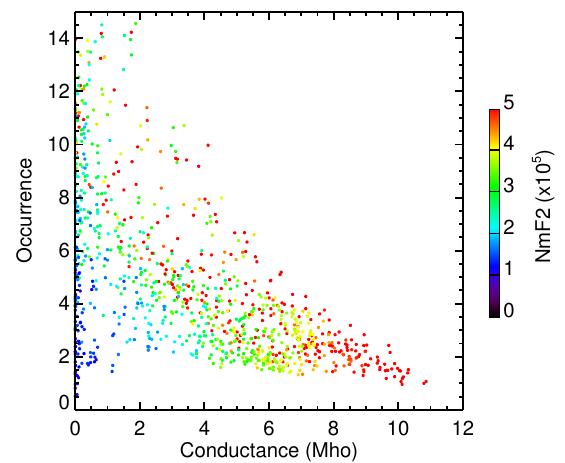
Fig. 5. Daytime radar echo occurrence versus model Pedersen con- ductance. Each point is color-coded according to the corresponding value of Nm F2, with the scale shown on the